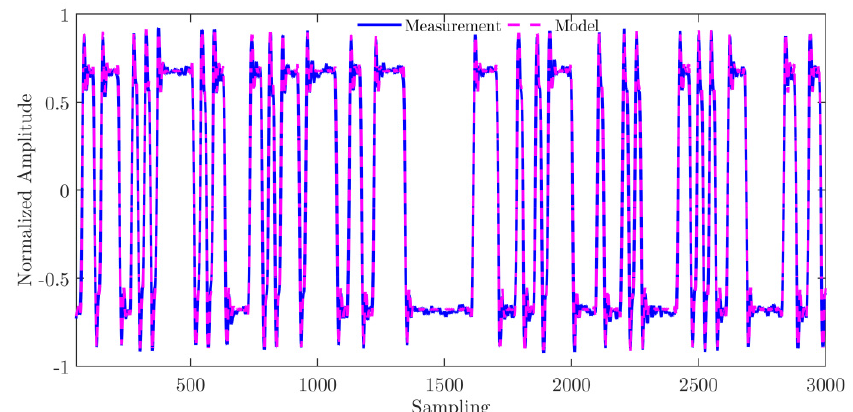
Figure 6. BIII-2 L5-Cd time-domain waveform.